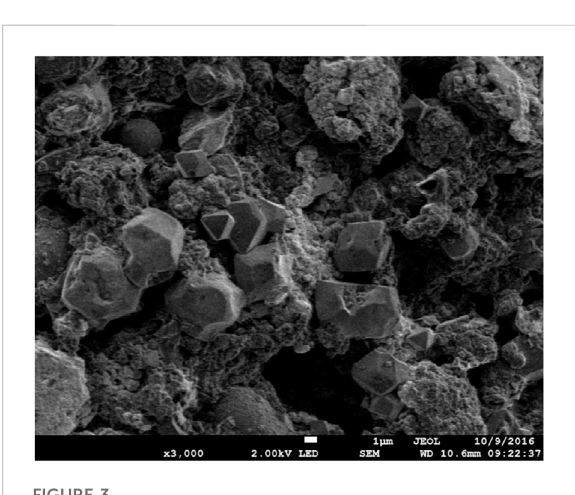
FIGURE 3 Micro-morphology of MSWI fl y